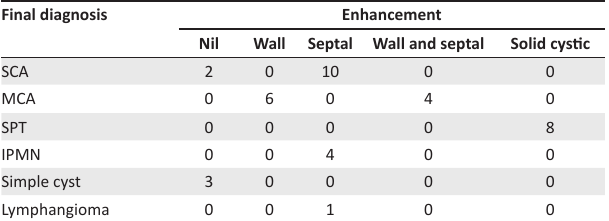
TABLE 3: Enhancement pattern on computed tomography of various pancreatic cystic lesions. Final diagnosis